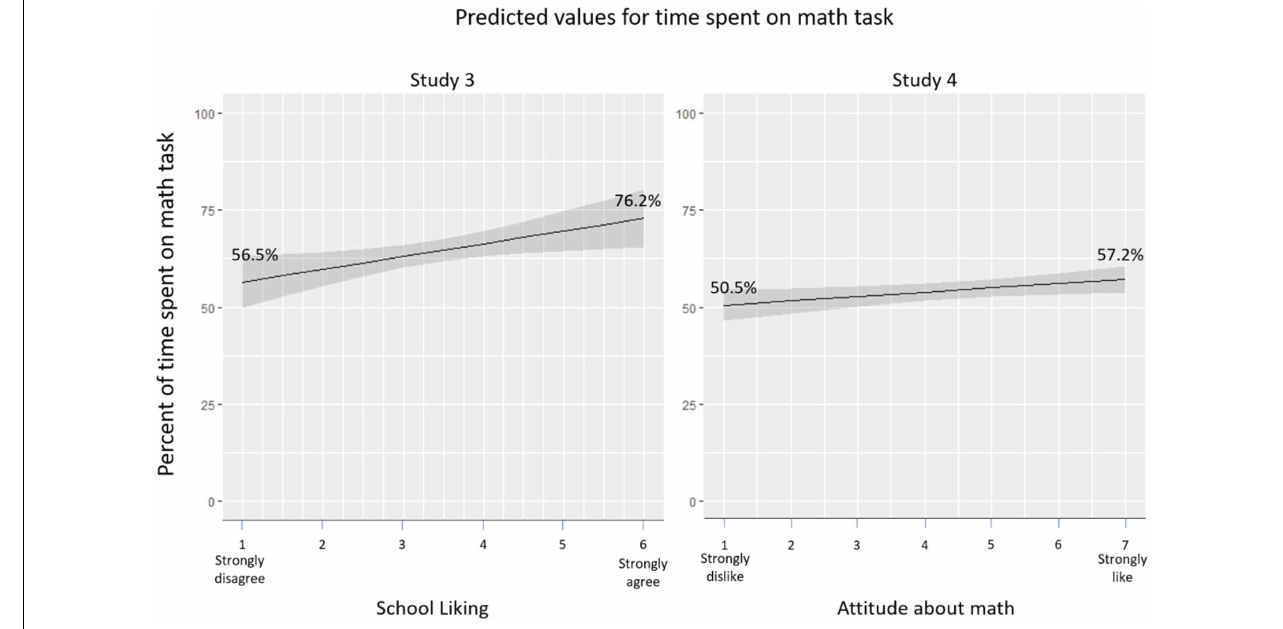
FIGURE 4 | Predicted percent of time spent on math task in Studies 3 and